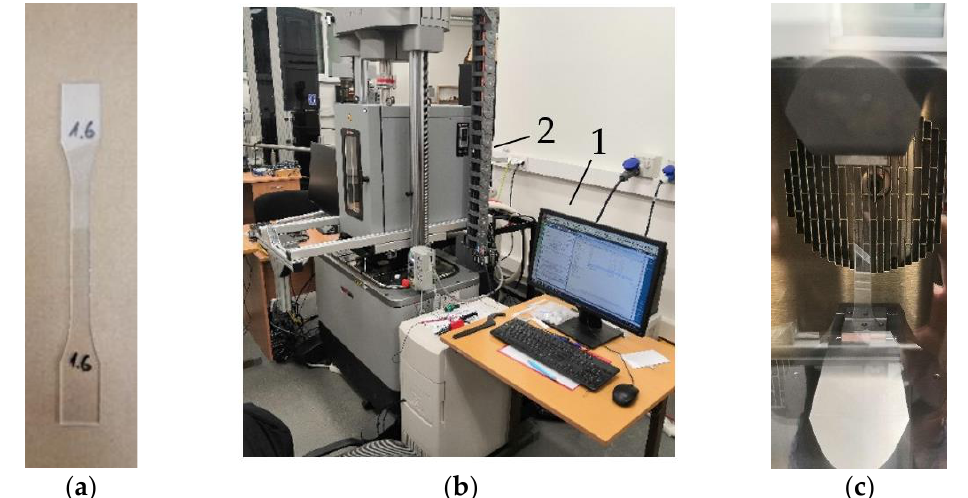
Figure 1. Tensile experiment: ( a ) Test specimen; ( b ) Testing machine Instron E10000: 1 — control computer, 2 — heating chamber and testing machine; ( c ) The test sample in the heating chamber.